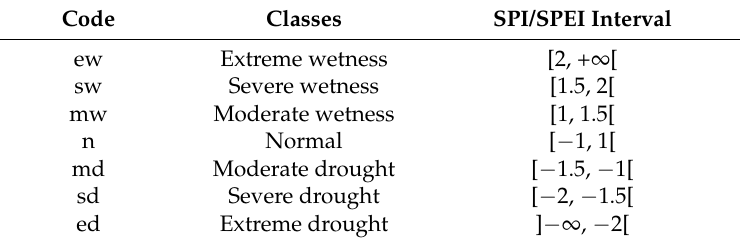
Drought and wetness classes of the Standardized Precipitation Index/Standardized Precipitation Evapotranspiration Index (Adopted from Mckee et al. [39]).